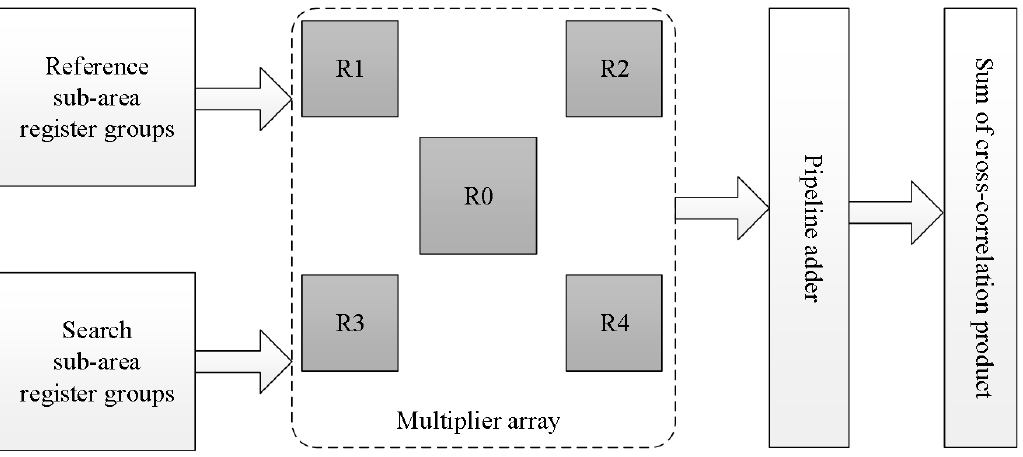
Figure 16. Calculating the sum of cross-correlation